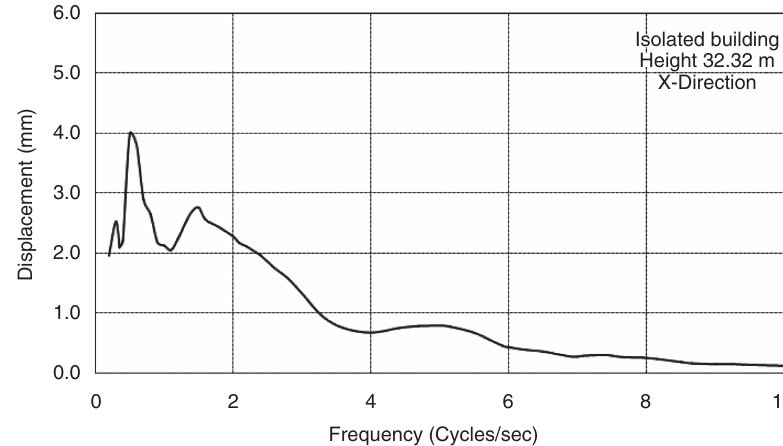
Fig. 16. Spectral Displacement in X-direction (isolated building)